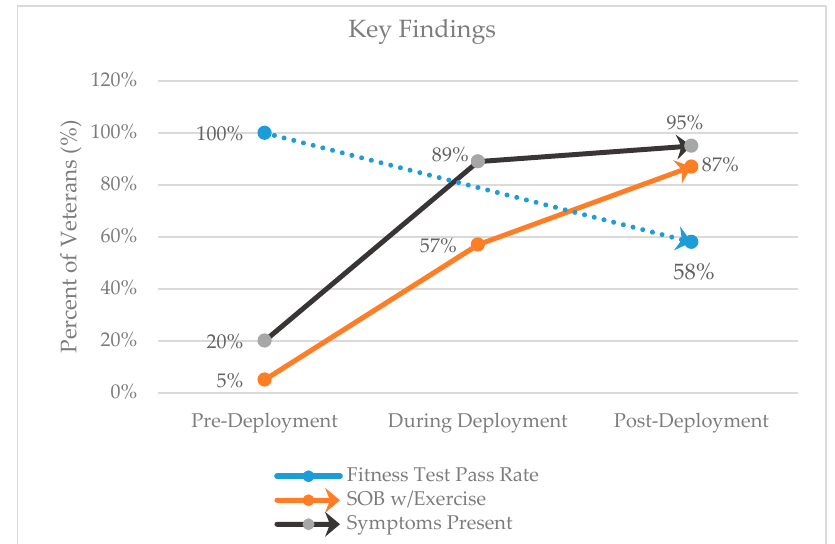
Figure 3. Respiratory related symptoms .